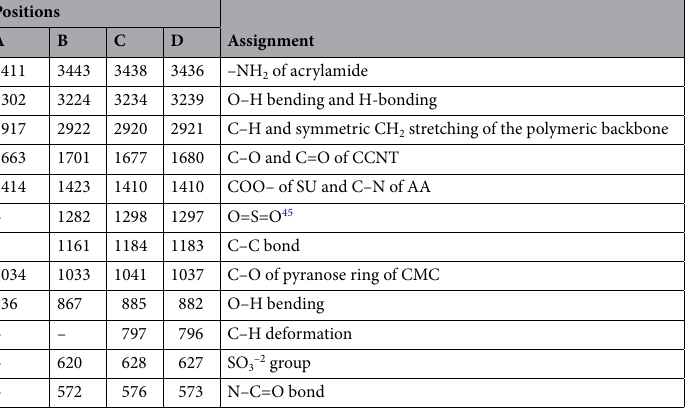
Table 1. The main FT-IR transmitted wavelength assignment of (A) virginal CMC/PVA/AA membrane. (B) CMC/PVA/AA-(4%) CSA. (C) CMC/PVA/AA-(4%) CSA-(2%) CCNT. (D) CMC/PVA/AA-(4%) CSA-(2%)